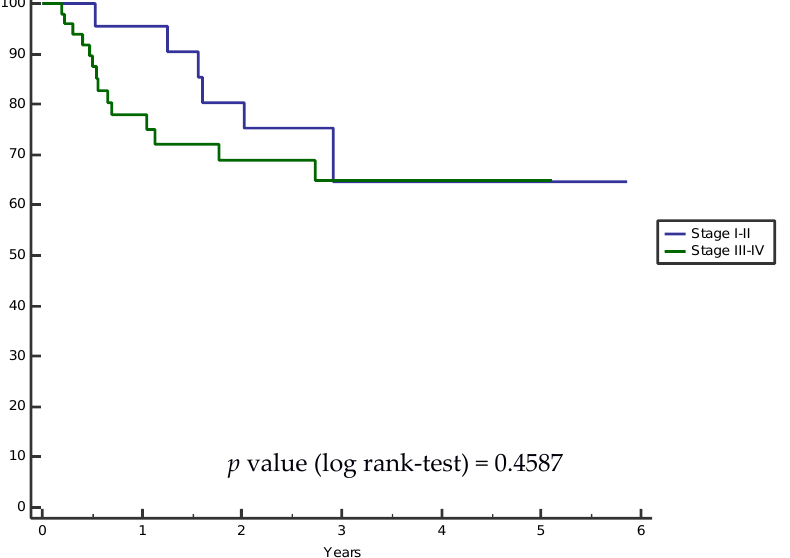
Figure 2. Kaplan–Meier progression-free grouped survival analysis: HNSCC stage I–II vs. III–IV. Figure 2. Kaplan – Meier progression-free grouped survival analysis: HNSCC stage I – II vs. III – IV. Three patients had treatment interruption, considered as the patient not receiving radiotherapy for more than 4 consecutive days. These three patients stopped treatment for a median of 7 days (SD ± 2.4 days). No significant difference was found between SMI variation and adverse events ( p -value =